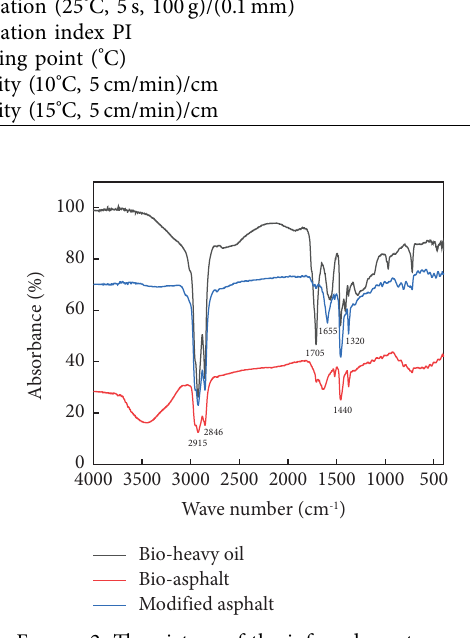
Figure 2: Te picture of the infrared